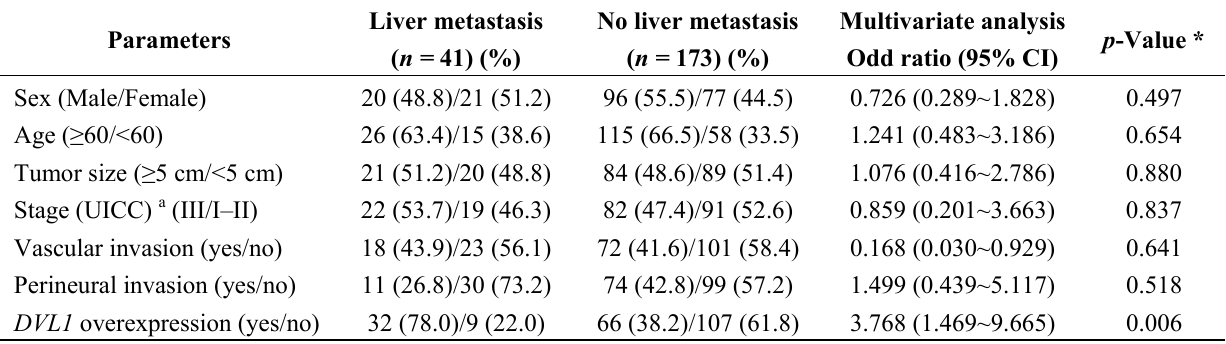
Table 4. Multivariate analysis of clinicopathological factors, DVL1 mRNA expression and liver metastasis status for 214 postoperative colorectal cancer